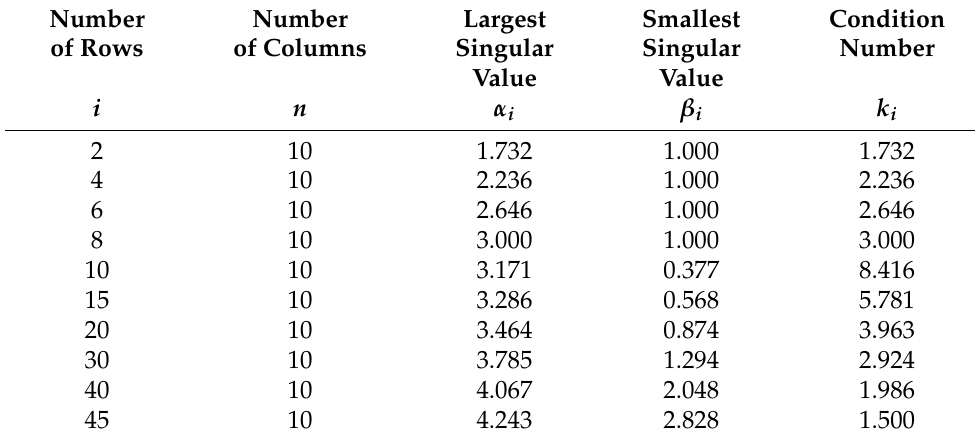
Table 1. The anomaly in small “two-ones” matrix.